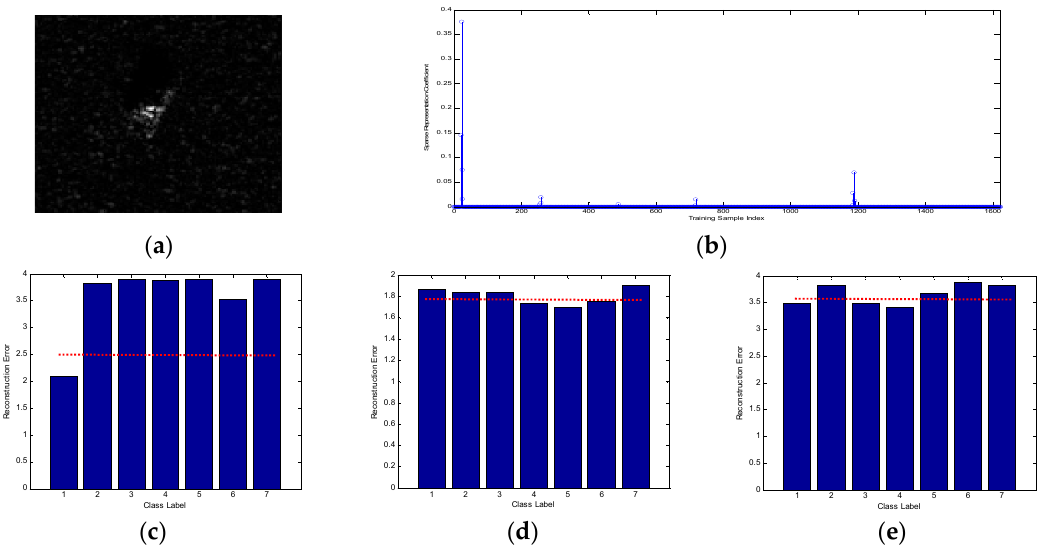
Figure 8. ( a ) Test sample BMP2-9563; ( b ) Sparse vector obtained based on ADNNLS algorithm; ( c ) Reconstruction error of ADNNLS algorithm; ( d ) Reconstruction error of SRC algorithm; ( e )